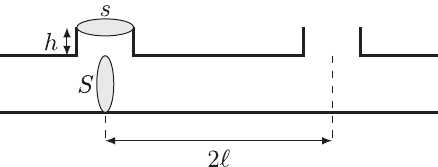
Figure 1. Geometrical dimensions of a tonehole pair. When repeated, this element forms a regular lattice with a cutoff frequency provided by equation